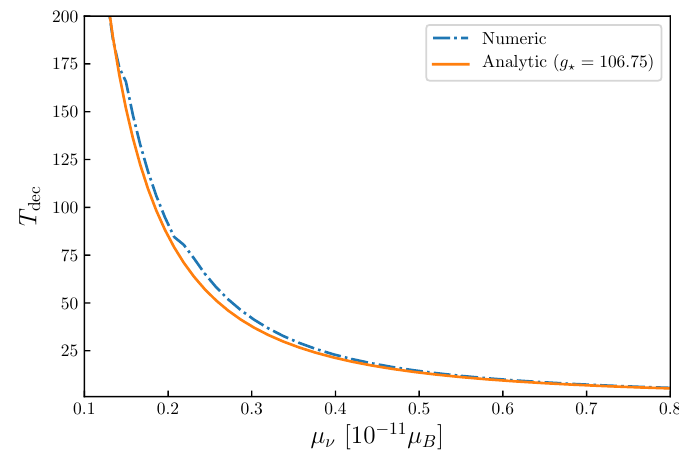
Figure 5 . The full numerical relation between the NMM µ ν and the decoupling temperature of right-handed neutrinos T dec . For comparison, the analytic relation in eq. (4.2) obtained by fixing g ? = 106 . 75 and h σvn i /T 3 = 6 . 47 is also